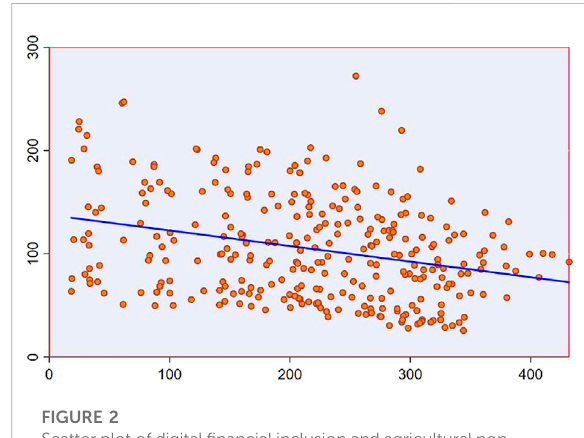
FIGURE 2 Scatter plot of digital fi nancial inclusion and agricultural non- point source pollution